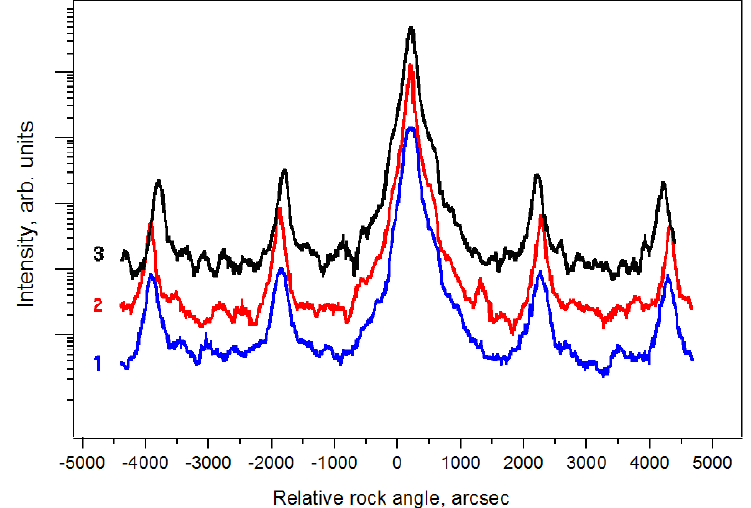
Figure 8. X-ray curves of the superlattice AlGaAs / GaAs epiwafers from one run (blue-epiwafer 1, red-epiwafer 2, black-epiwafer 3).